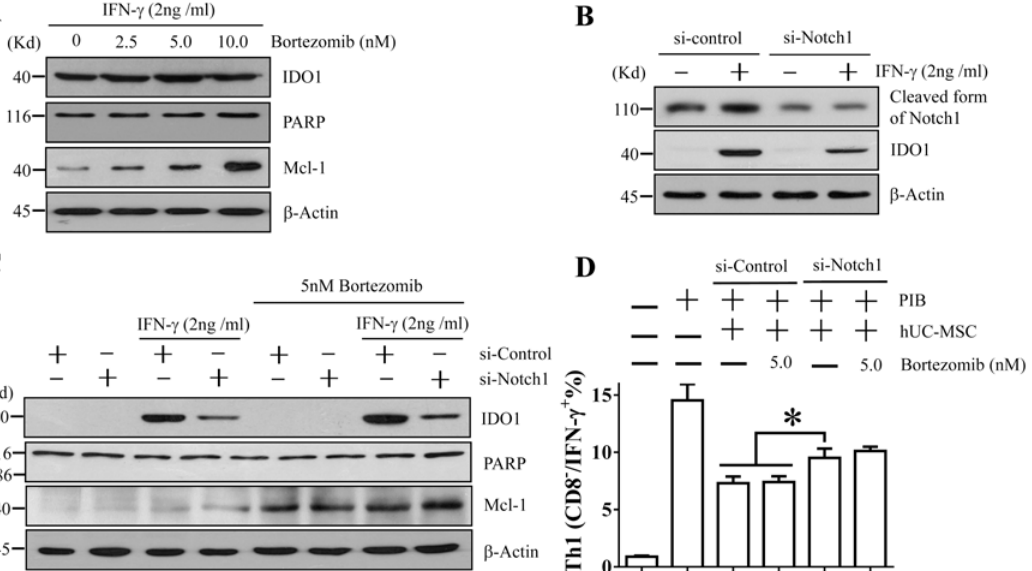
Fig 7. The Notch signaling plays a predominant role in maintaining immunomodulatory activities of hUC-MSCs. A. Western blotting shows that Bortezomib alone does not affect the IFN- γ -induced IDO1 expression, does not induce apoptosis as no PARP cleavage was induced, but elevates Mcl-1 protein level. B. Western blotting shows that siNotch1 transfection can silence approximately 50% of IDO1 protein expression, but does not induce apoptosis. C. Western blotting shows that treatment with 5 nM Bortezomib does not further enhance the effect of siNotch1 transfection on IDO1 reduction. In addition, Bortezomib and siNotch1 together do not induce apoptosis as no PARP cleavage is observed. D. The flow cytometry assay shows that siNotch1 transfection alone can significantly reduce the inhibitory effect of hUC-MSCs on Th1 lymphocyte proliferation. Bortezomib alone shows no such effect and does not enhance the effect of siNotch1 either. The * indicates statistical significance with p <